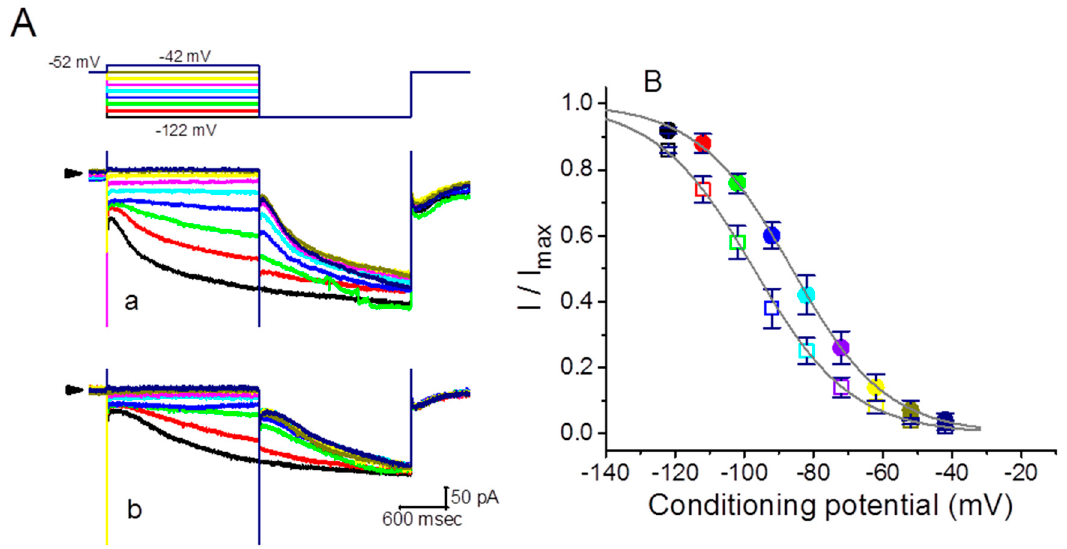
Figure 3. Effect of GTs on the steady-state activation curve of I h measured from GH 3 cells. The recording experiments were conducted in a two-step voltage pulse. The conditioning voltage pulses with a duration of 2 sec to potentials ranging from − 122 and − 42 mV. After each conditioning pulse, a test pulse to − 122 mV with a duration of 2 sec was applied to evoke I h . (A) Representative I h traces evoked by this two-step protocol. Current traces labeled a are the control, and those labeled b were obtained in the presence of 10 µg/mL GTS. The uppermost part is the voltage protocol applied, arrowhead in the left side of each panel denotes the zero current level, and calibration mark at the right lower corner applies all current traces in (A). Notably, colored labeling in each current trace (lower part) in the absence (a) and presence (b) of GTs corresponds to that in voltage trace (upper part). (B) Steady-state activation curves of I h obtained in the absence (closed symbols) and presence (open symbols) of 10 µg/mL GTs (mean ± SEM, n = 9 for each point). Current amplitude was taken at the end of hyperpolarizing pulse. The sigmoidal smooth lines indicate the least-squares fit to the Boltzmann equation detailed in Materials and Methods. Colored labeling in each point corresponds to that in (A)